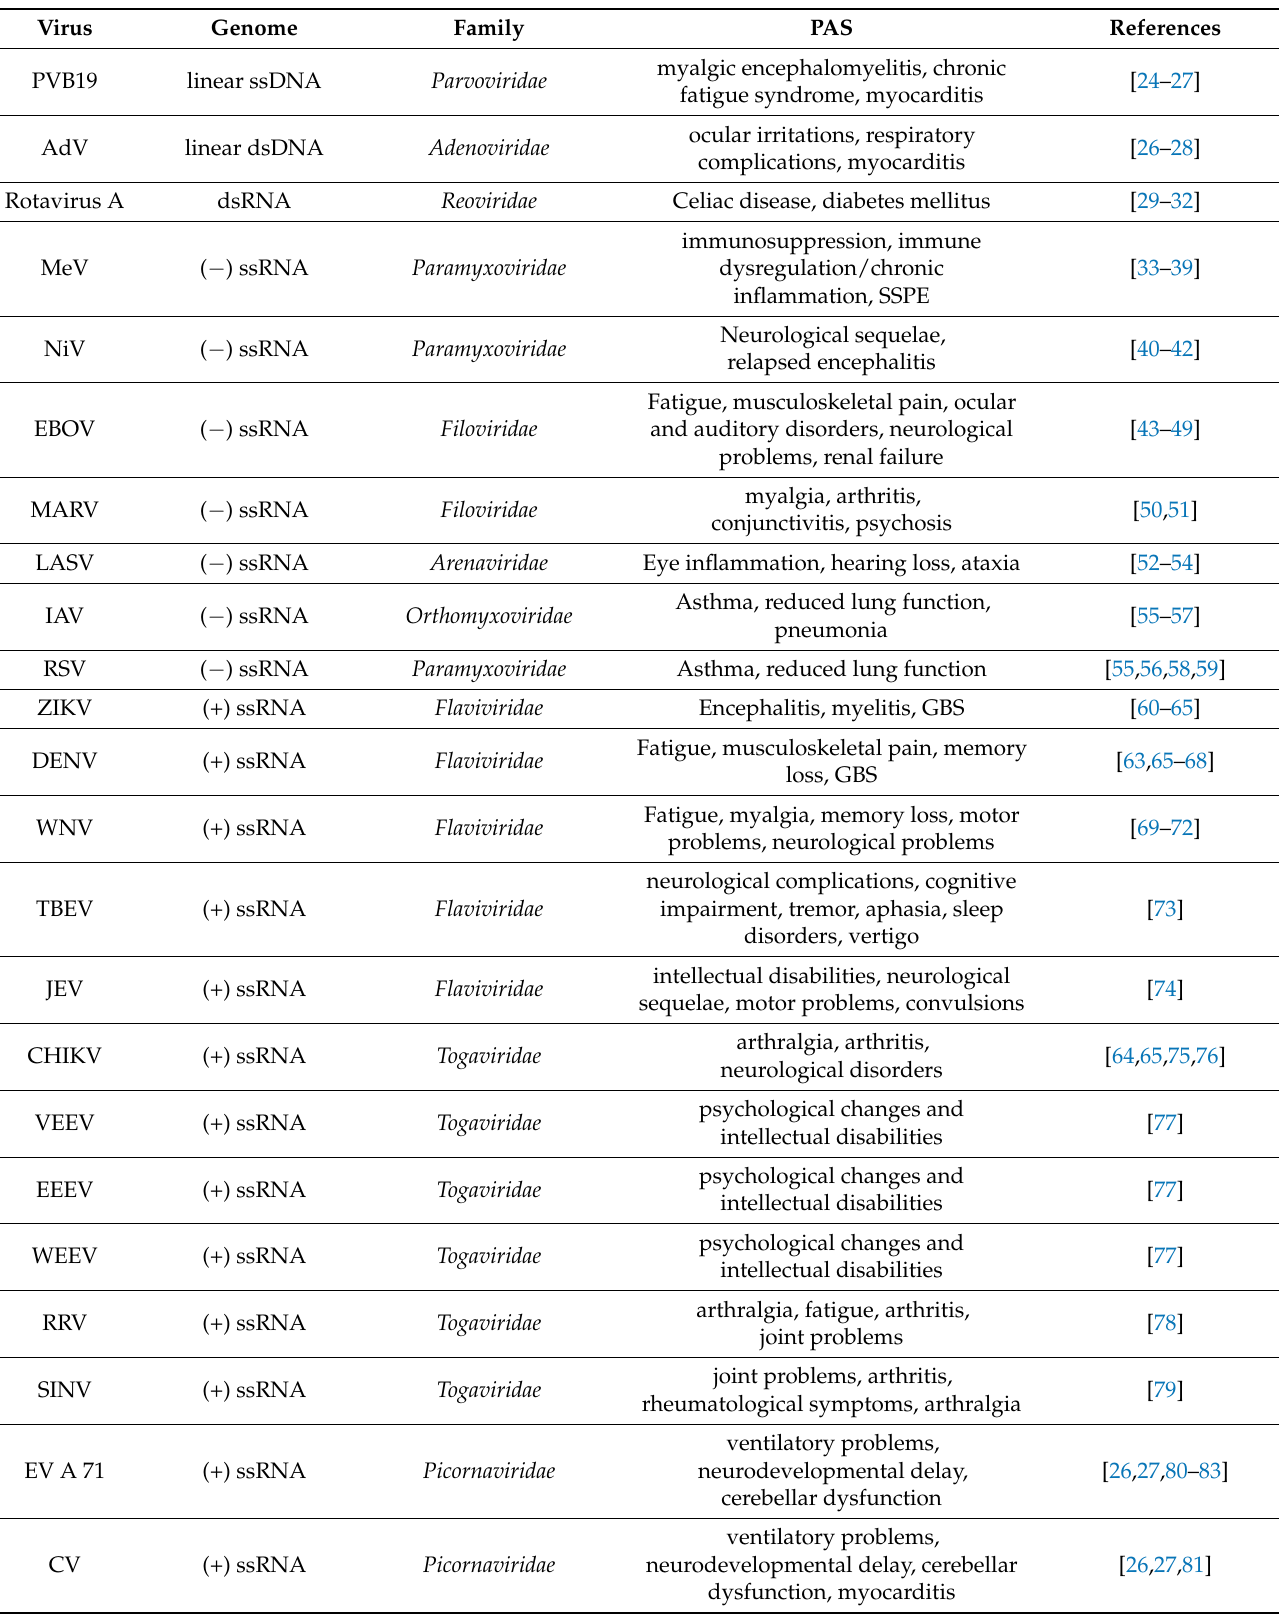
Table 1. Overview of non-persistent viruses and post-acute